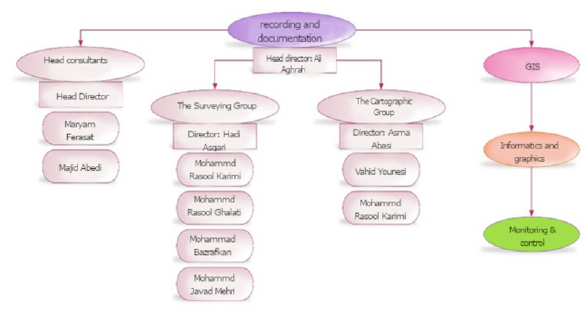
Table 1. Roles and Teams